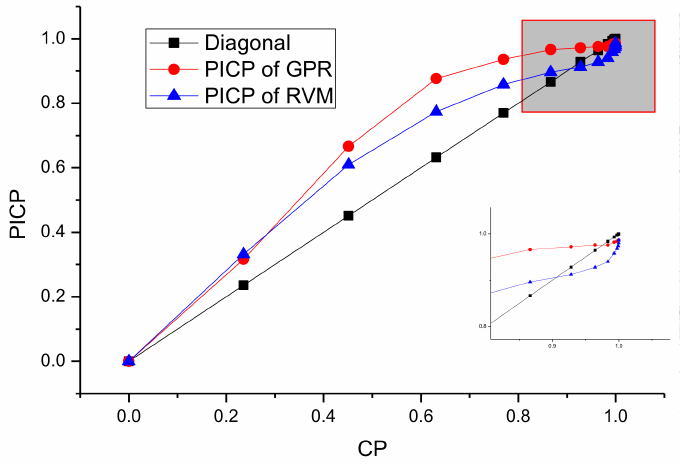
Figure 11. ROC-PI curves of RVM and GPR for battery voltage series.